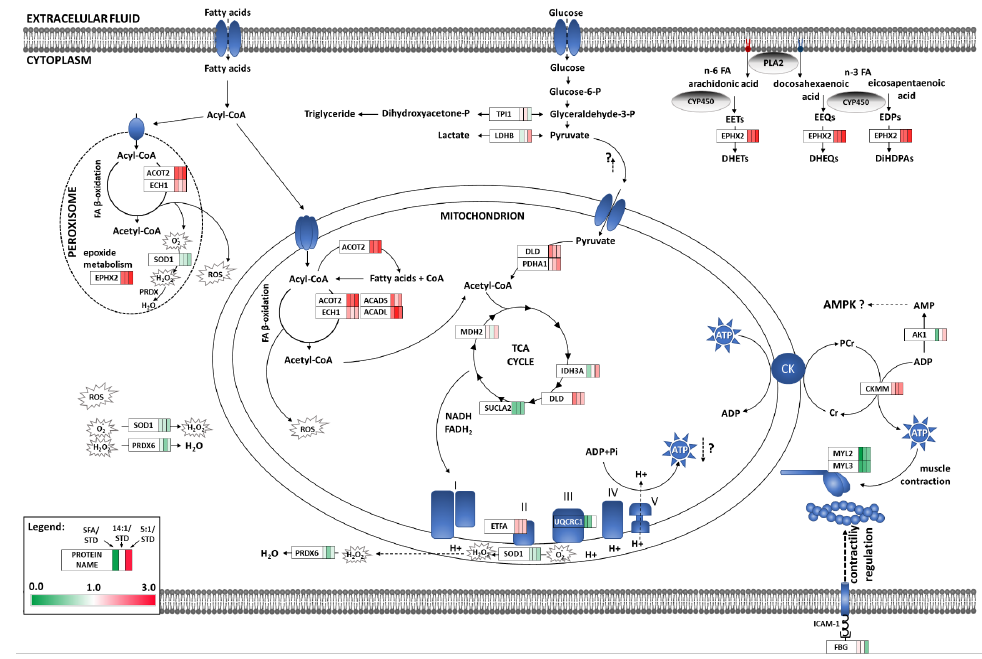
Figure 5. Overview of the effects of high-fat diets on the cardiomyocyte proteome. Identified proteins are shown according to the magnitude of fold-change in comparison to the STD group; red indicates upregulated proteins and green downregulated proteins in the myocardium of mice. EETs—epoxyeicosatrienoic acids; DHETs—dihydroxyeicosatrienoic acids; EEQs—epoxyeicosatetraenoic acids; DHEQs—eicosatetraenoic acids; EDPs—epoxydocosapentaenoic acids; DiHDPAs—dihydroxydocosapentaenoic acids; AMPK—AMP-activated kinase.